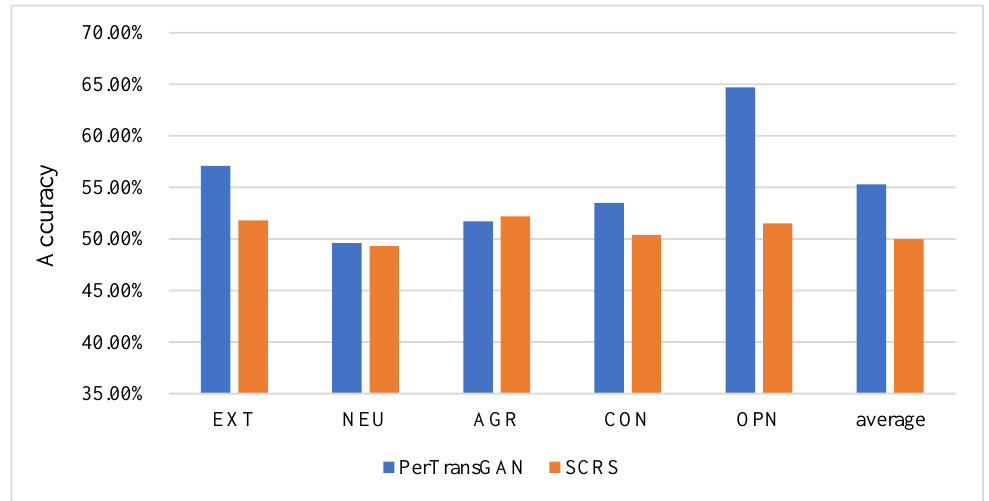
Figure 3. Comparison of the experimental results.